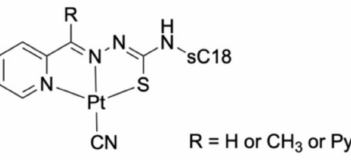
Figure 5. Chemical structure of the final platinum complex, according to reference [42].